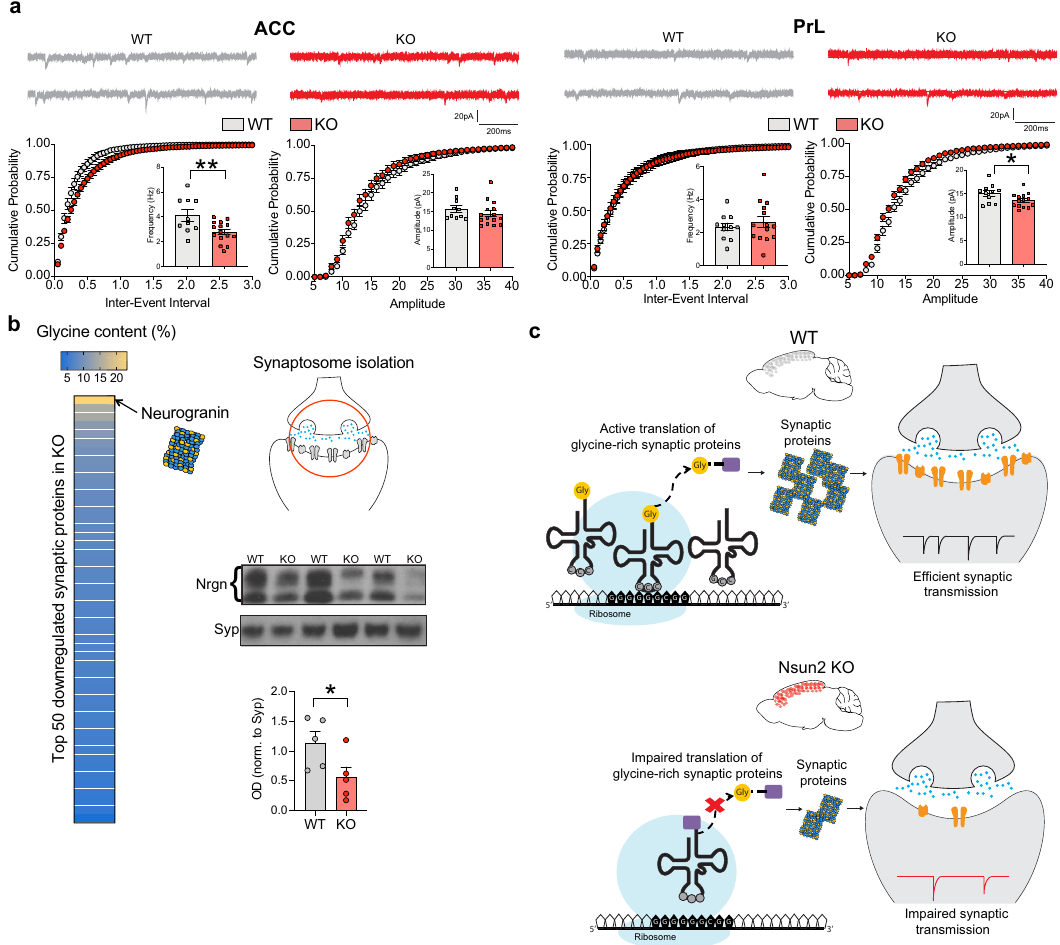
Fig. 4 Neuronal Nsun2 is essential for synaptic transmission in the prefrontal cortex. a Electrophysiological recordings from two distinct PFC subregions, ACC (left; n = 10 WT neurons, 15 KO neurons) and PrL (right; n = 11 WT neurons, 14 KO neurons) in WT and Nsun2 KO mouse brain. mEPSCs were recorded from layer V pyramidal neurons at − 70 mV (two-tailed t test, ** P = 0.007, * P = 0.035). Data are presented as mean values + / − SEM. b Left, glycine content for 50 downregulated synaptic proteins (see Supplementary Table 3) that may contribute to synaptic transmission phenotype, including Neurogranin with 23% glycine. Right, synaptosomes were isolated from Nsun2 KO cortex and immunoblot showed decreased expression of Neurogranin at the synapse in KO cortex ( n = 5 WT/5 KO; one-tailed t test, * P = 0.026). Synaptophysin, which was unaltered in our proteomics screen, was used as a loading control. Data are presented as mean values + / − SEM. c Working model for effects of Nsun2 KO on tRNA Gly expression, translation of synaptic proteins, and resulting impairments in synaptic transmission. Source data are available as a Source Data fi